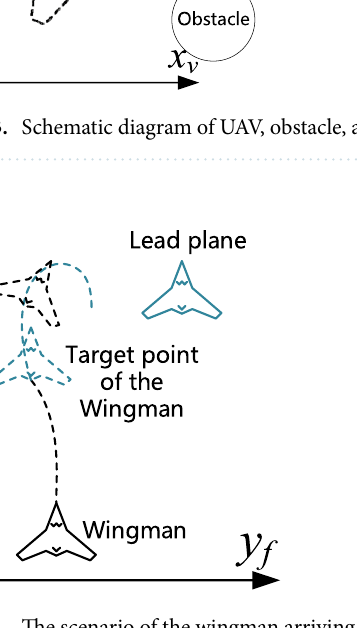
Figure 4. The scenario of the wingman arriving at a target